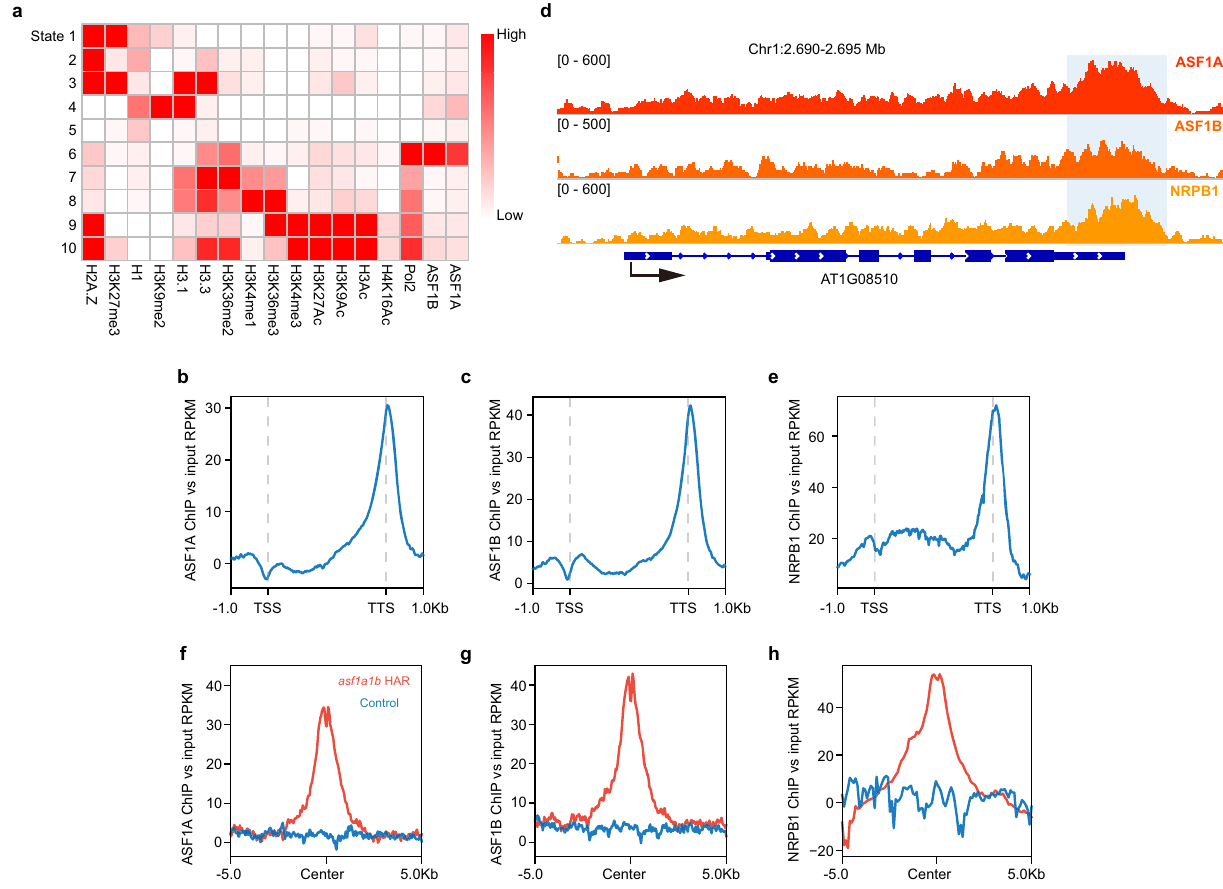
Fig. 4| GenomicdistributionofASF1sandNRPB1.a OverlappingofASF1protein distribution with the distribution of histone variants and histone modi fi cation marks.Darkerredintheheatmapindicatesahigheroverlapping.State1tostate10 represents chromatin environments de fi ned by ChromHMM according to the enrichment ofASF1A/ASF1Band 15 ChIP-seq datasets. b Metaplot shows the ASF1A ChIP-seqsignaldistributionoverthegenebody,including1Kb fl ankingsequences. c Metaplot shows the ASF1B ChIP-seq signal distribution over the gene body,